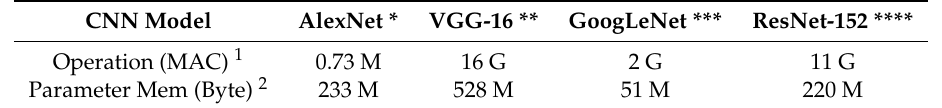
Table 1. Computation and parameter size requirements in a convolutional neural network [19].